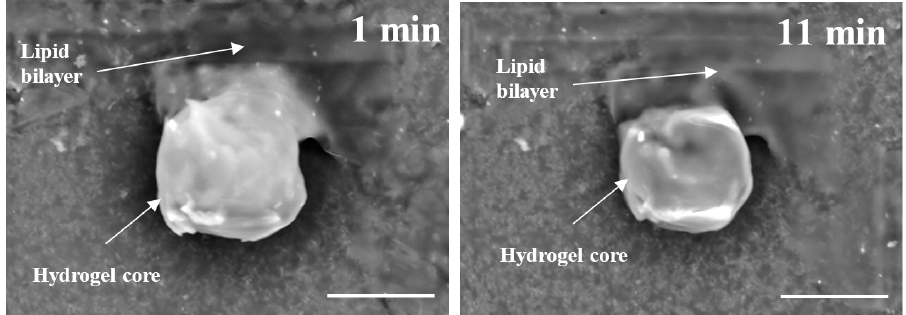
Figure 7. The temporal changes in a lipobead morphology under the scanning electron beam (15 kV) in high vacuum (~50 Pa). The lipobead is prepared by polymerization inside a GUV and deposited on the carbon conductive tab preliminary adhered on the SEM mounting stub (scale bars = 20 µm).